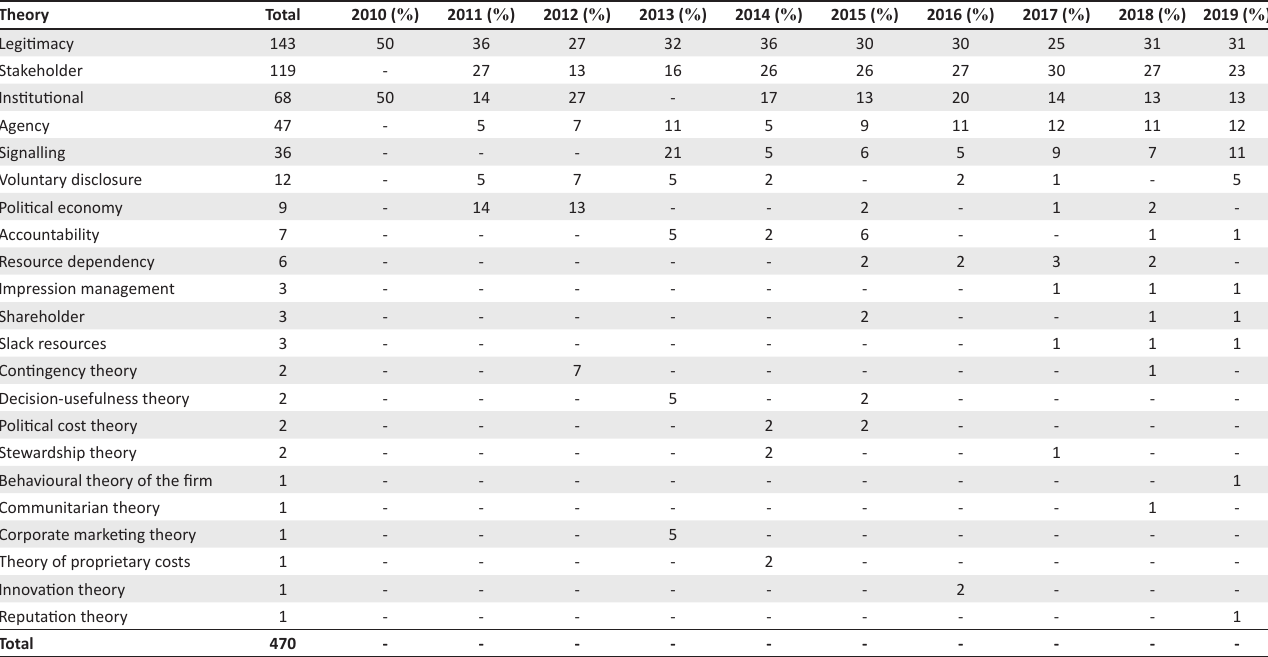
TABLE 5: Occurrence of each theory in sustainability reporting literature in total, and as a percentage of the total per year.